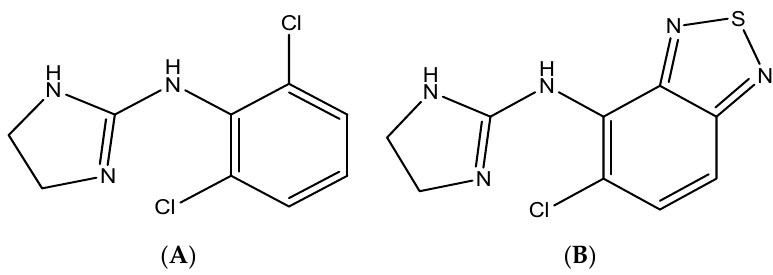
Figure 1. Chemical structure of ( A ) clonidine and ( B ) tizanidine (IS).